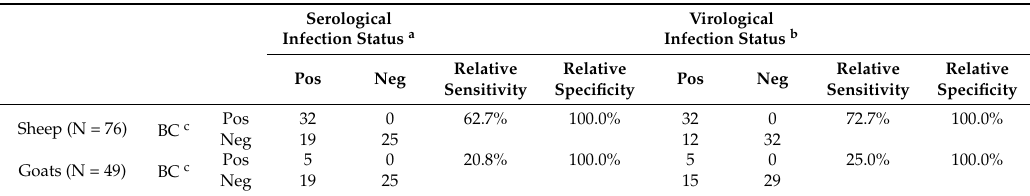
Table 7. 2 × 2 contingency tables comparing qPCR results obtained in blood clots from sheep and goats to the serological and virological infection